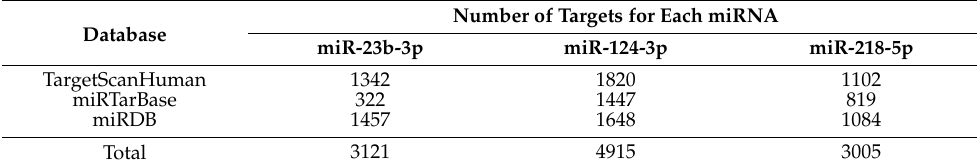
Table 2. Target mRNAs with MREs specific for miR-23b-3p, miR-124-3p, and miR-218-5p.